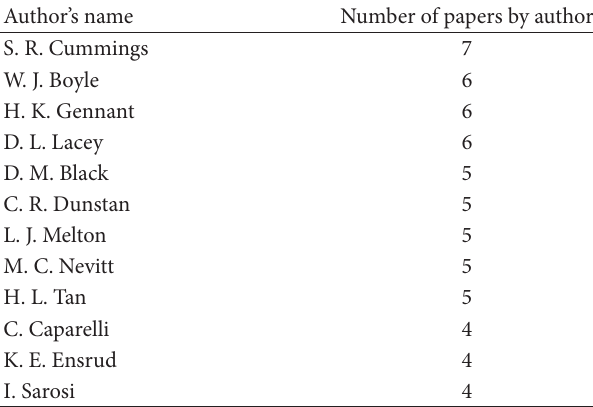
Table 4: Top 12 authors who contributed to the top 50 list. Figure 3: Distribution of countries.